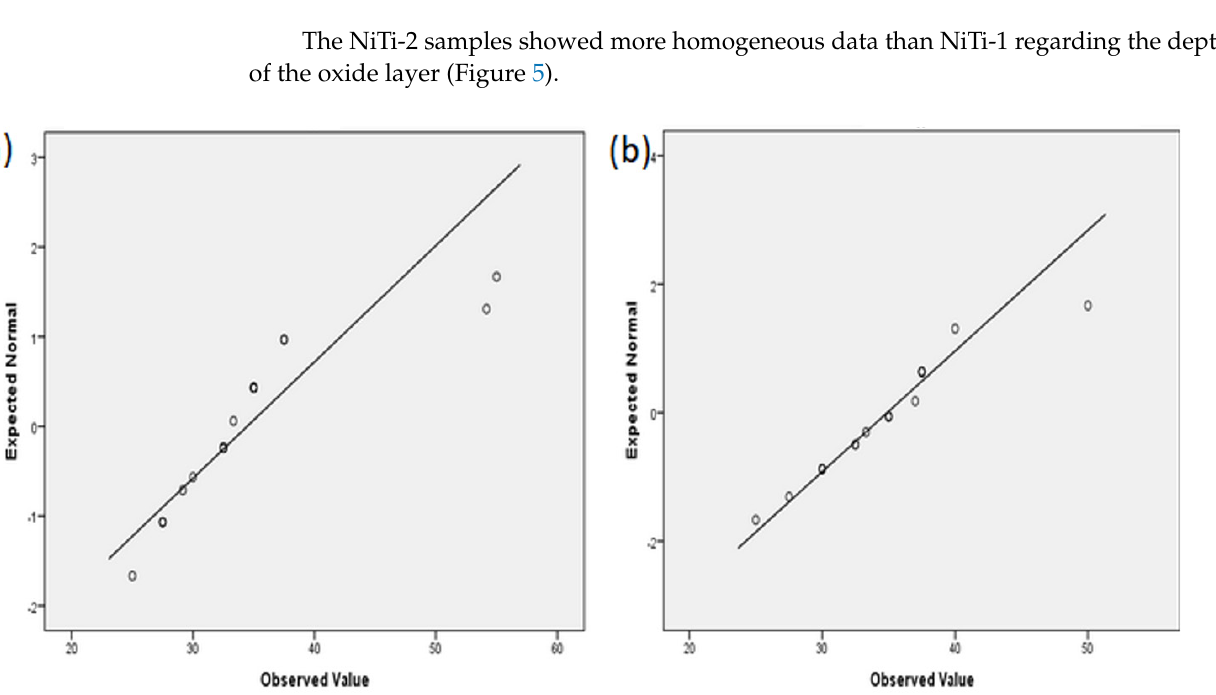
Figure 5. Normal Q − Q plot of the oxide layer thickness: ( a ) NiTi-1 sample; ( b ) NiTi-2 sample